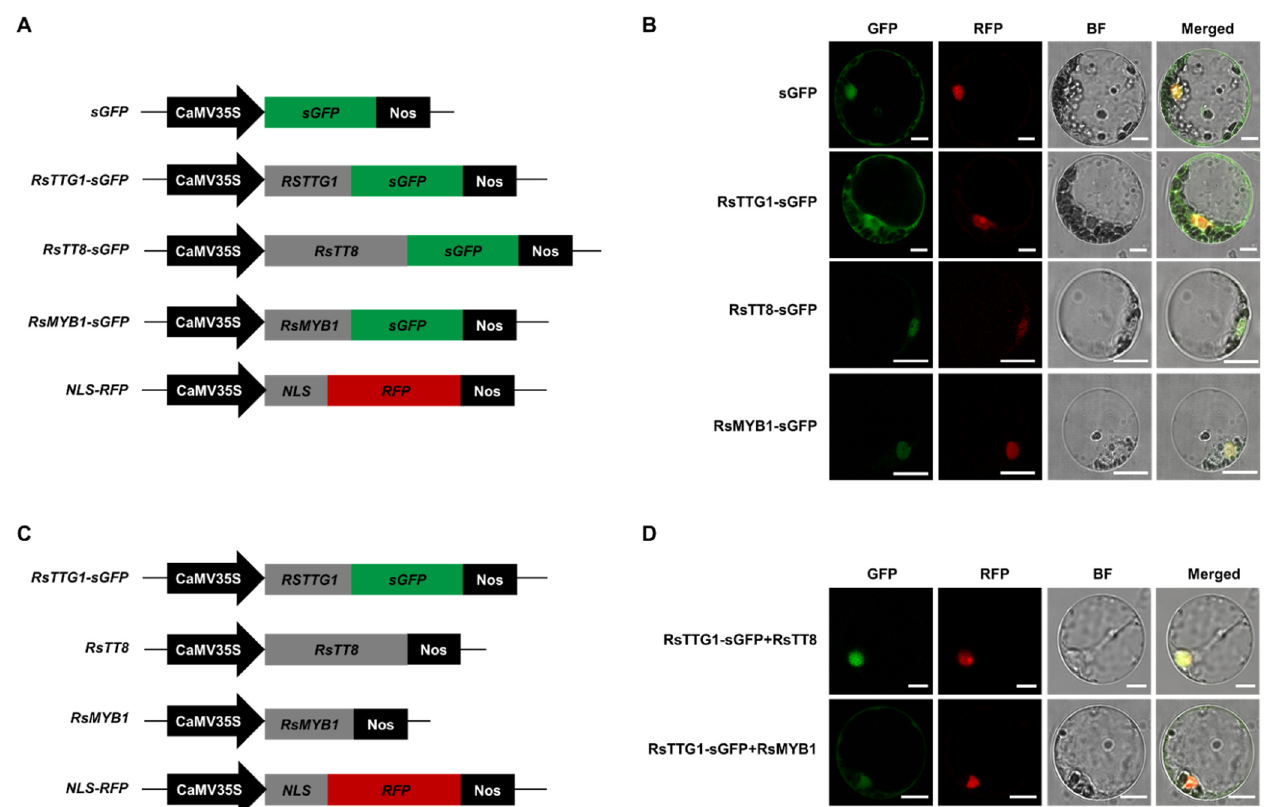
Figure 5. Proper intracellular localization of RsTTG1 is dependent on its interaction with RsTT8. ( A ) Schematic diagram of the constructs used in this experiment: sGFP , soluble GFP; RsTTG1-GFP ; RsTT8-GFP ; RsMYB1-GFP ; and NLS-RFP (red fluorescent protein with nuclear localization sequence). ( B ) In vivo localization pattern of RsTTG1, RsTT8, and RsMYB1 in Arabidopsis protoplasts. Representative protoplasts accumulating each fusion protein are shown 16 h after transformation. Bars, 10 μ m. ( C ) Schematic diagram of the constructs used in this experiment with different combinations of constructs. ( D ) In vivo intracellular localization pattern of RsTTG1, RsTT8, and RsMYB1 in Arabidopsis protoplasts. Representative protoplasts accumulating each fusion protein are shown 16 h after transformation. Bars, 10 μ m.